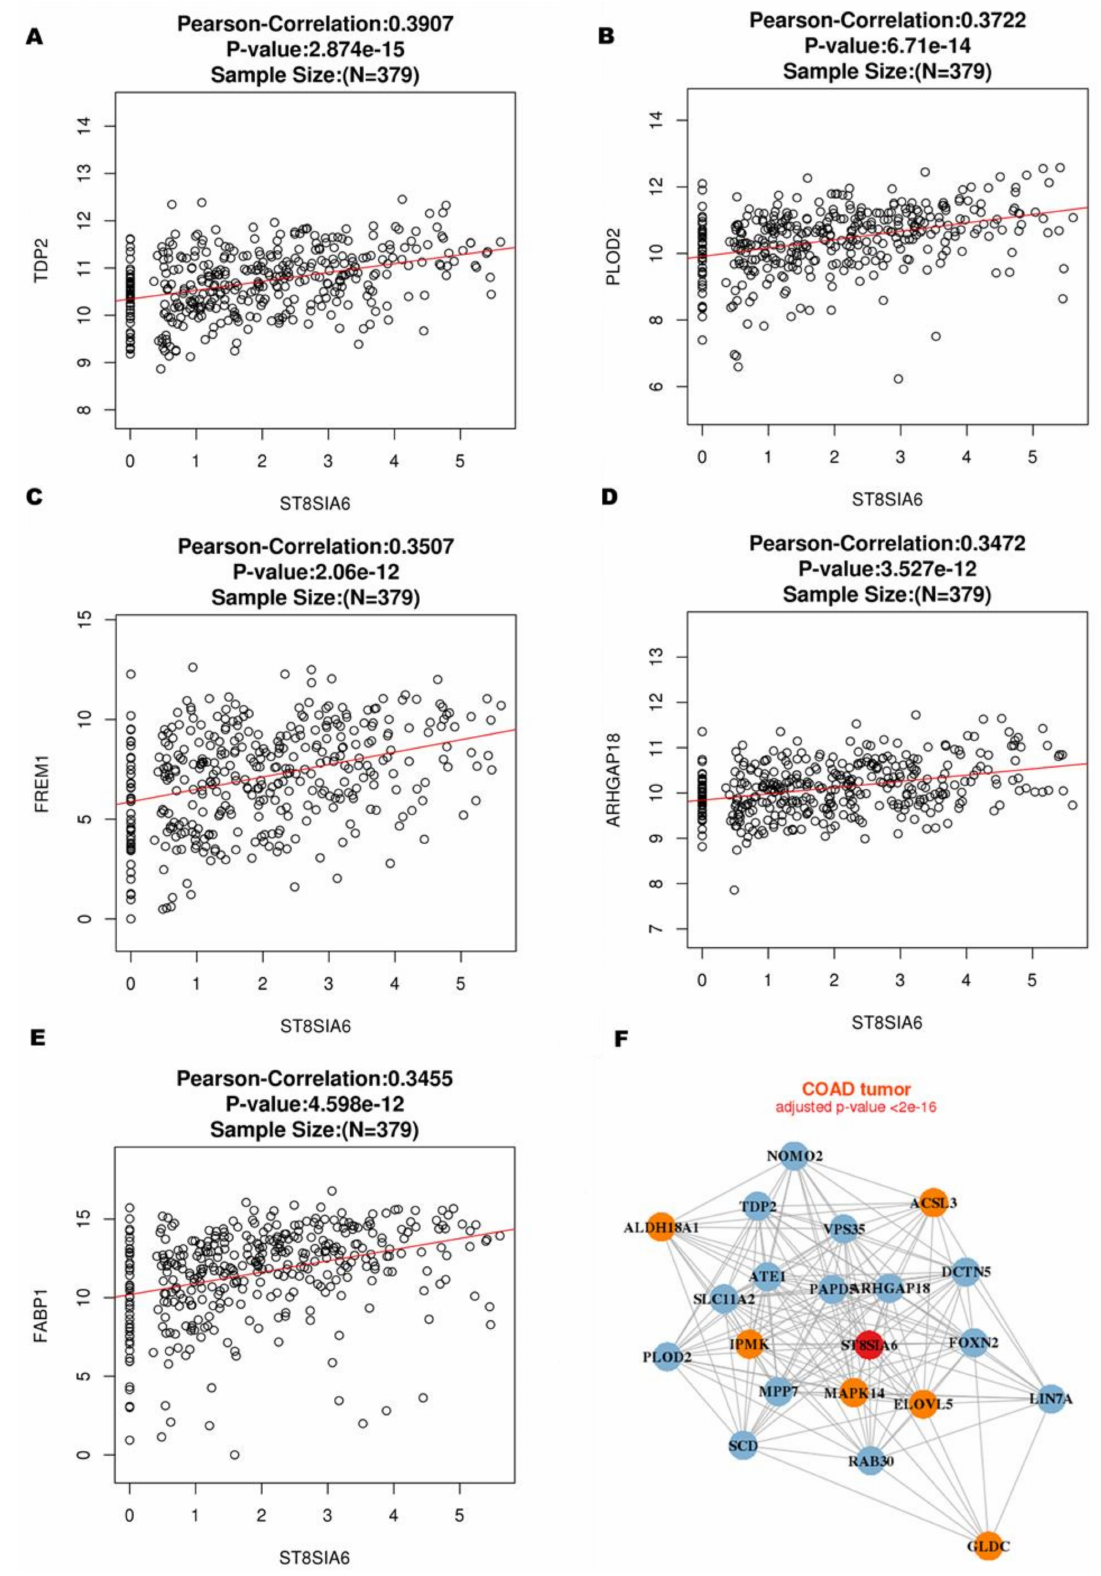
Figure 4. The positive genes correlated with ST8SIA6 involved a metabolic pathway in colon cancer. ( A – E ) Top 5 co-expressed genes with the highest correlation with ST8SIA6 in colon cancer. ( F ) Gene– Gene interaction network of ST8SIA6 and differentially co-expressed genes from ccmGDB. Red nodes represent input gene, oranges nodes represent cell metabolism